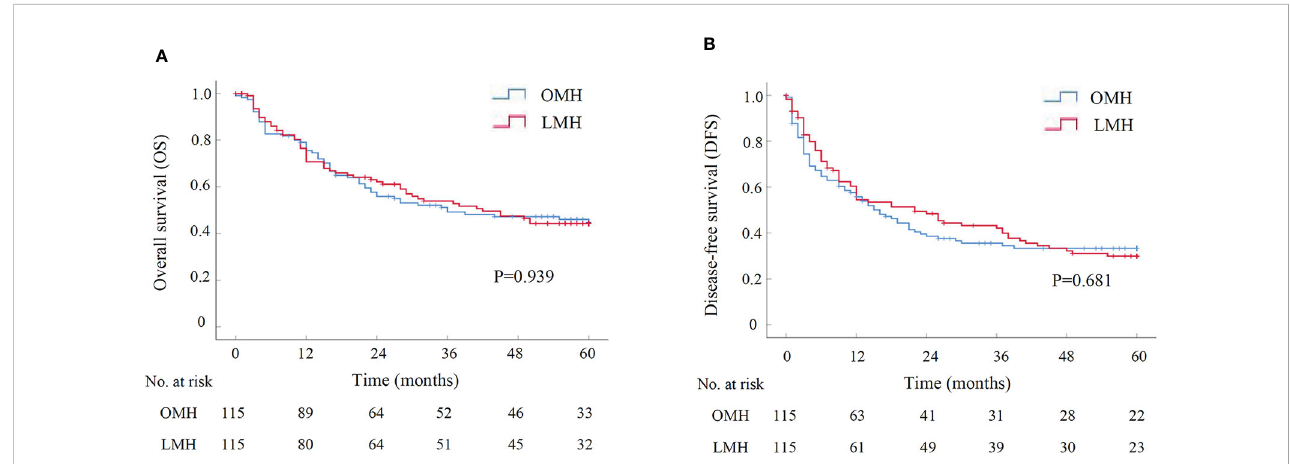
FIGURE 3 The survival curve of LMH versus OMH for HCCs after PSM by Kaplan-Meier analysis (N=115 for each group). (A) Overall survival; (B) Disease-free survival. LMH, laparoscopic major hepatectomy; OMH, open major hepatectomy; PSM, propensity score